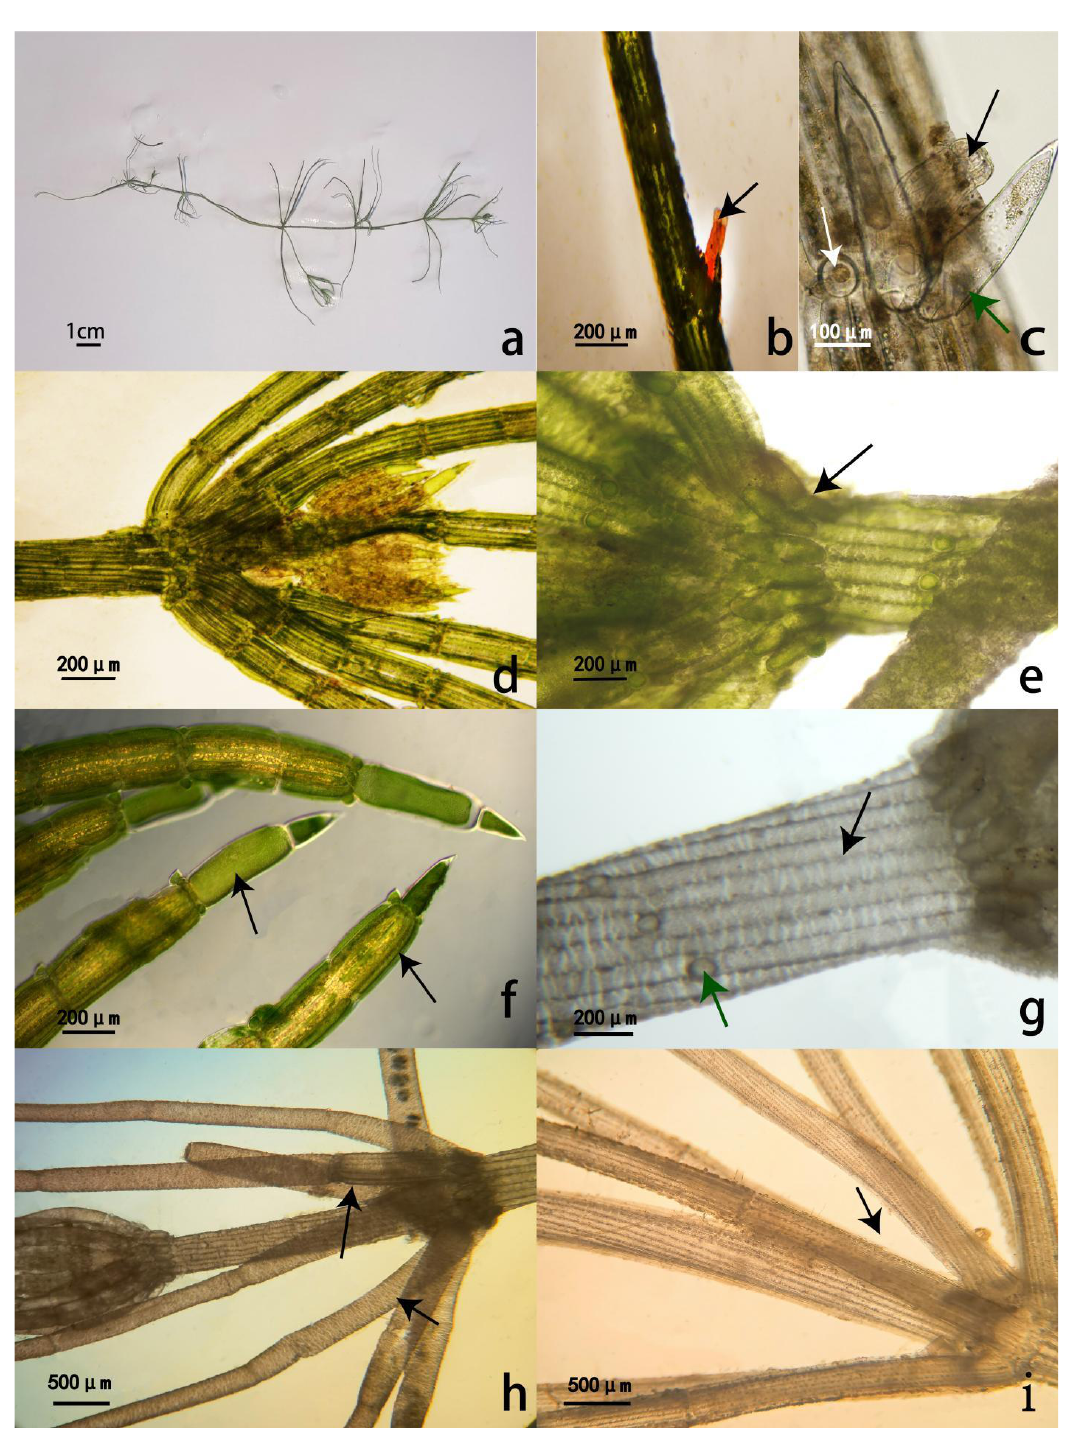
Figure 3. Morphological characteristics of Chara zhengzhouensis collected in Zhengzhou, China. ( a ) Thallus; ( b , c ) oogonium (black arrow), bract cells (white arrow) and bracteoles (green allow); ( d,e ) whorl with stipulodes; ( f ) ultimate segments of branchlets ; ( g ) stem with cortex (black arrow) and spine cells (green arrow); ( h , i ) based segments of branchlets corticate or ecorticate.